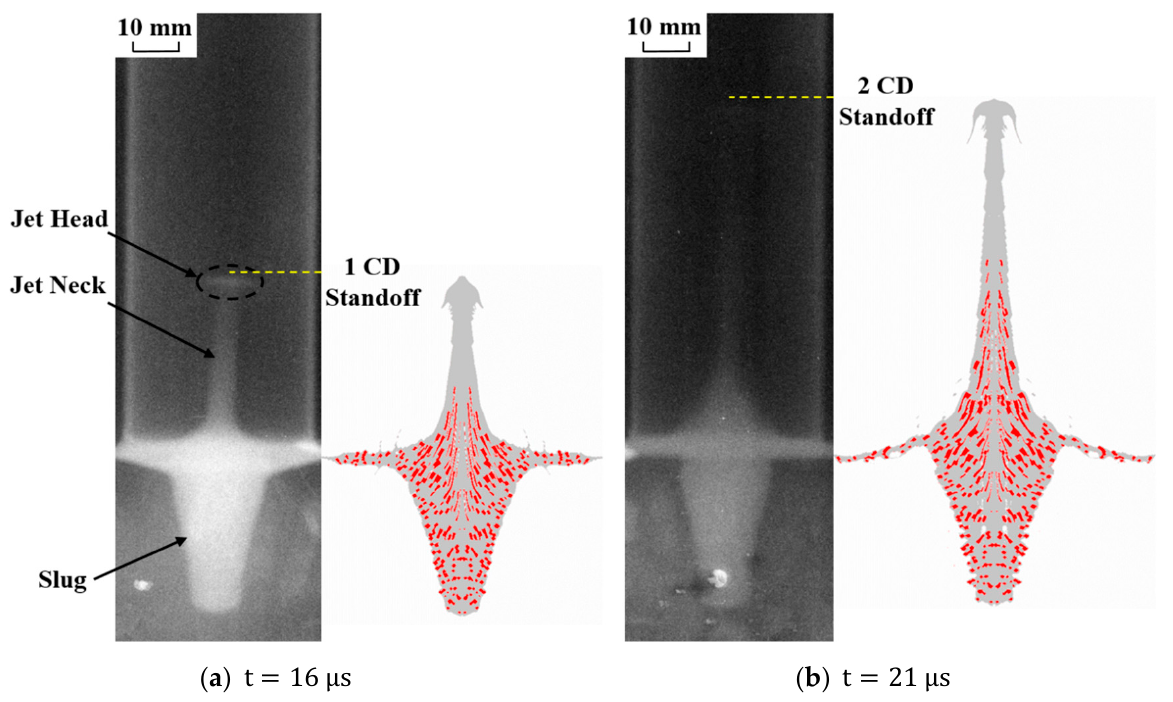
Figure 7. Comparison between experimental and simulated results.